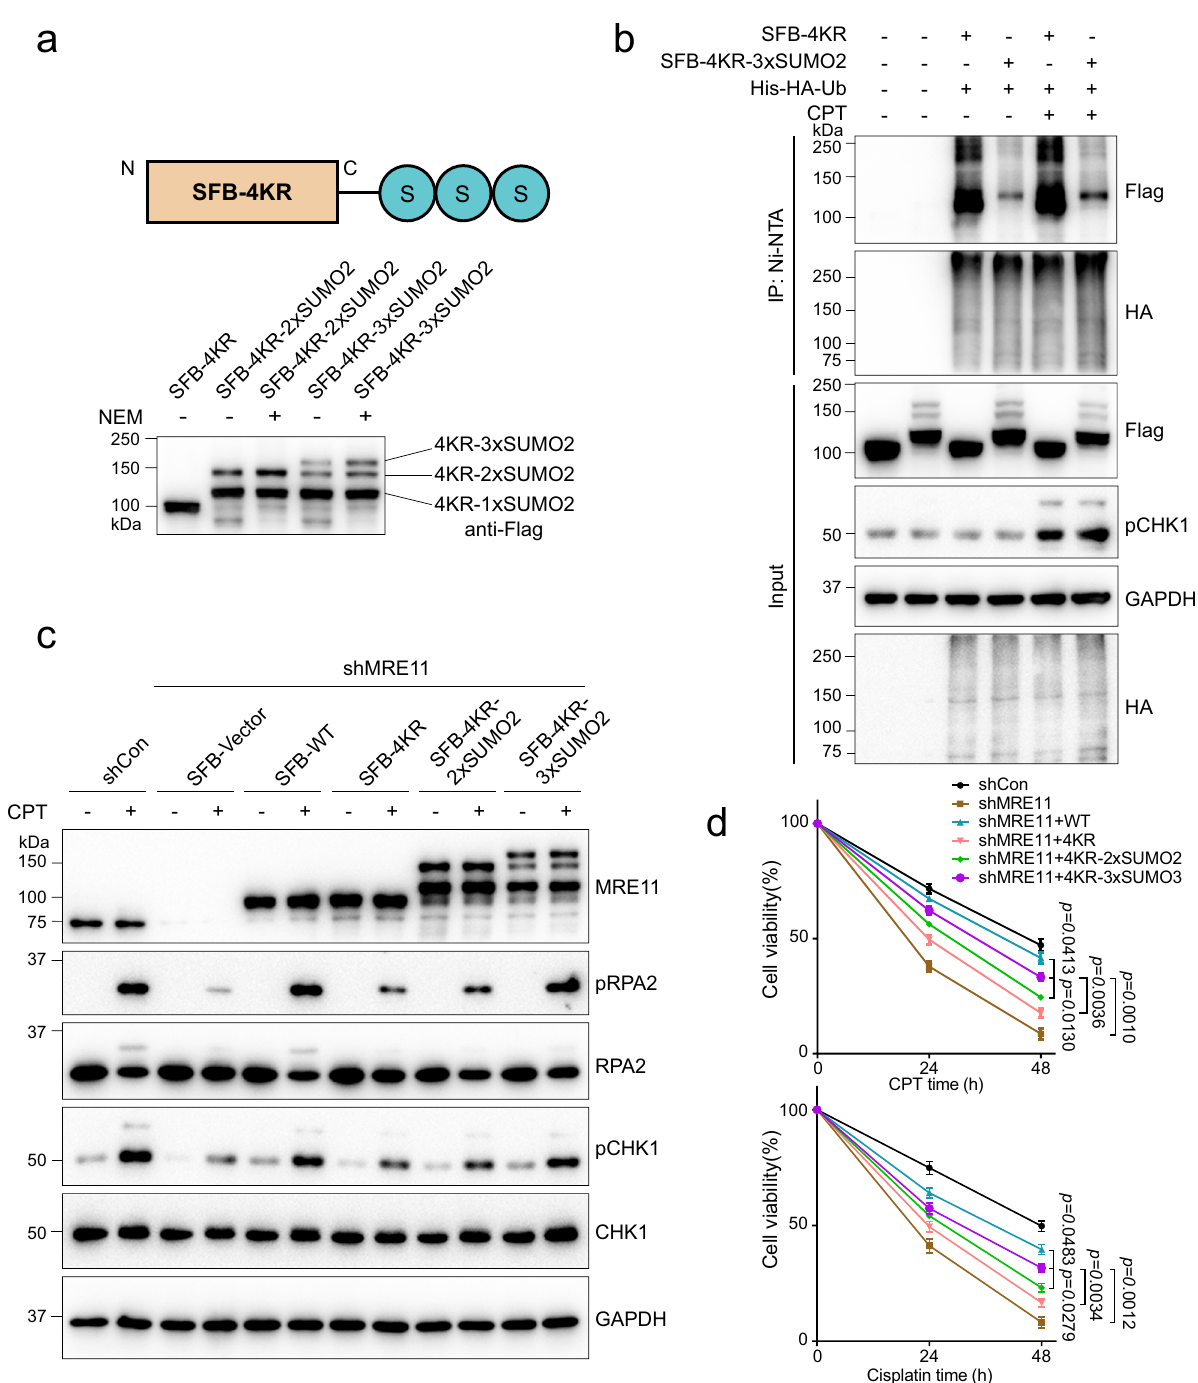
Fig.6|ThestabilityofSUMOylation-de fi cientMRE11isimprovedbyfusionwith apoly-SUMO2chain.a Schematicofthe4KR-MRE11proteinwitha3×SUMO2chain fused to the C-terminus. Fusion protein expression was detected by immunoblot- ting. b The ubiquitylation of 4KR was inhibited by fusion with the 3×SUMO2 chain. c SUMOylation-de fi cient MRE11 fused with poly-SUMO2 facilitated RPA2